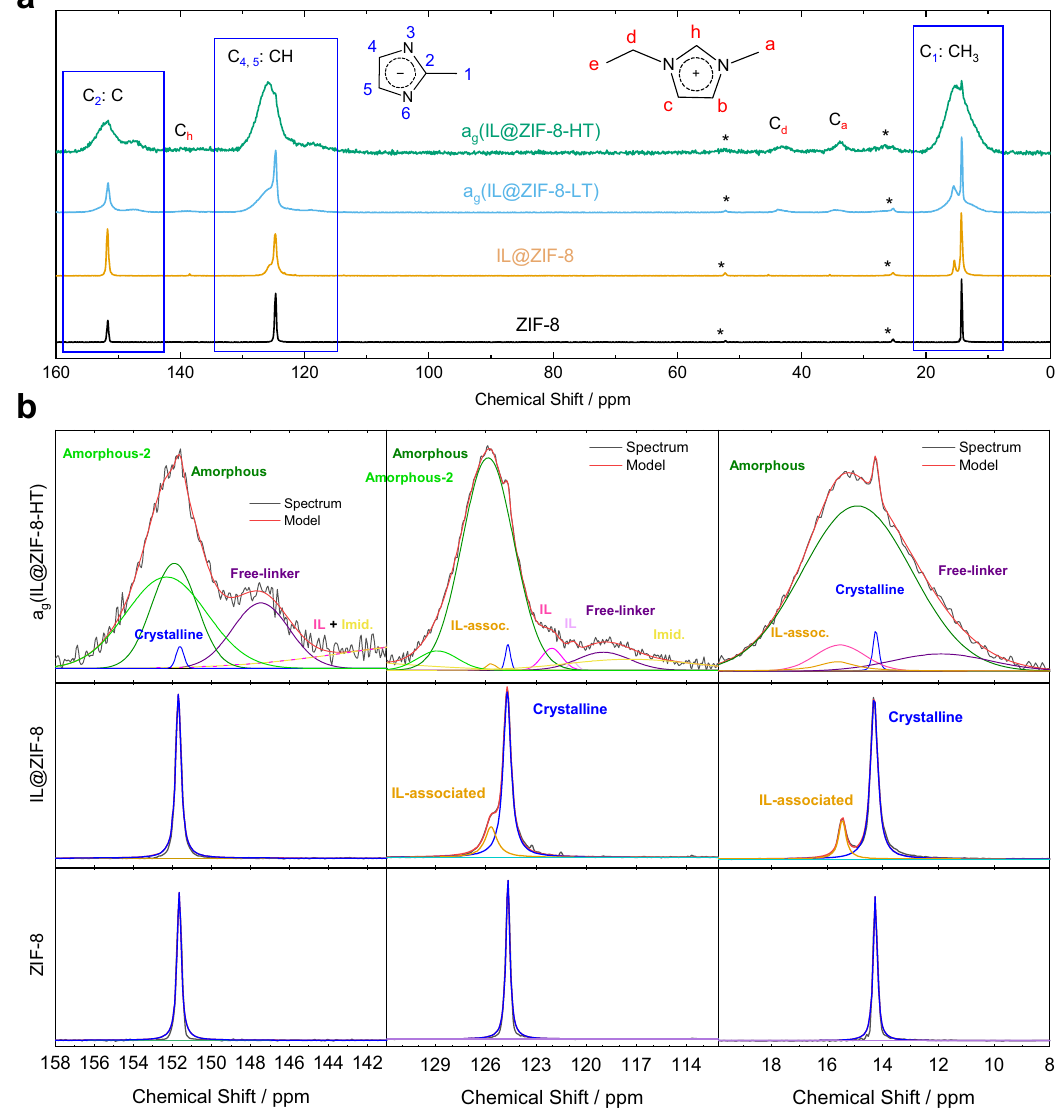
Fig. 4 1 H- 13 C CP NMR analysis of mIm carbons in ZIF-8. a 1 H- 13 C CP NMR of ZIF-8, IL@ZIF-8, a g (IL@ZIF-8-LT), and a g (IL@ZIF-8-HT). Spinning sidebands are marked with asterisks. b Insets of fi ts for C 2 :C, C 4 , 5 :CH, and C 1 : CH 3 (methyl) carbons. For the fi ts of a g (IL@ZIF-8-LT) please see Supplementary Fig.